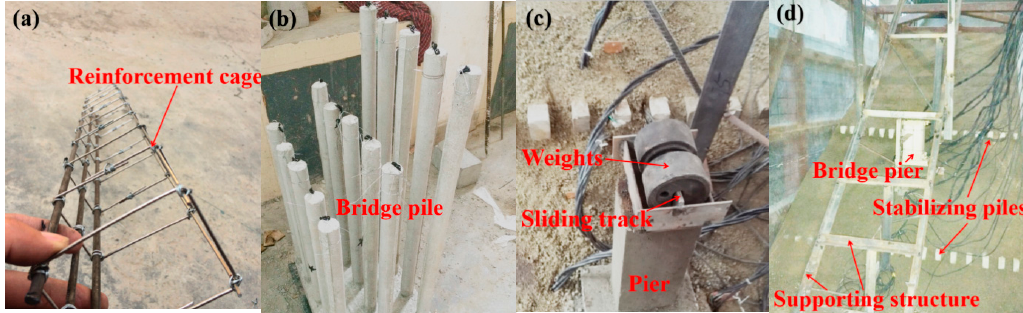
Figure 5. Photographs of model construction. ( a ) Reinforcement cage; ( b ) bridge pile foundation; ( c ) box girder simulation; ( d ) test model.